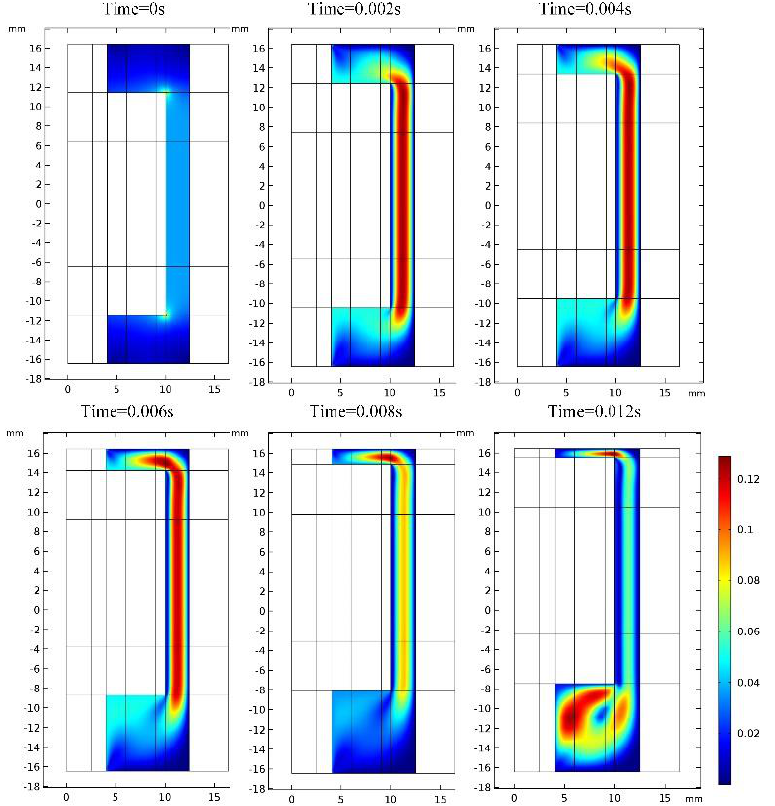
Figure 10. Velocity distribution map of the MR fluid when the current is 0 A.